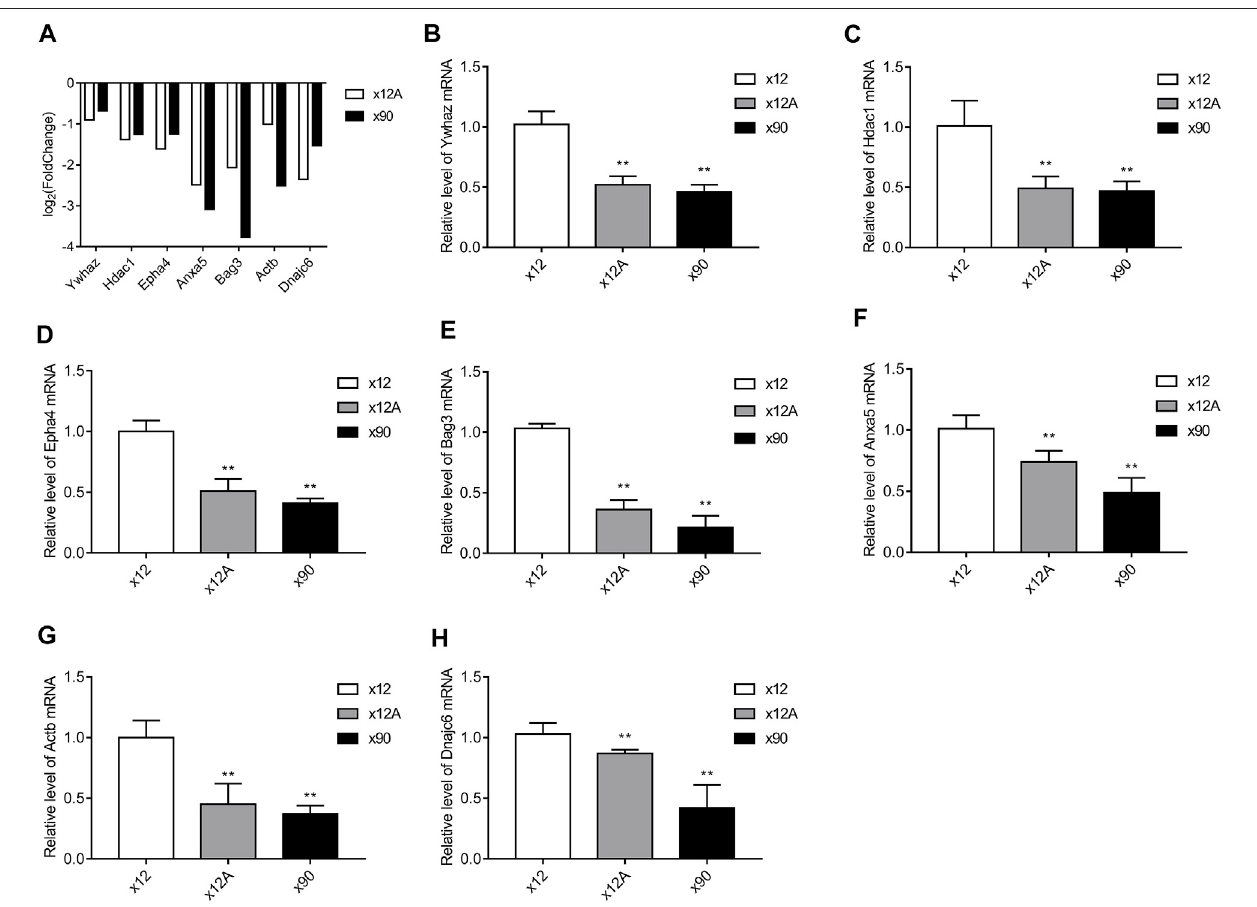
FIGURE 10 | Resultsof RT-qPCR validation. The hub genes obtained from screening against the Alzdata database were matched against the sequencing results. RT-qPCR was used to detect the expression levels of these genes in A β -treated and naturally senescent astrocytes. (A) Expression levels of these genes in transcriptomesequencing,expressedaslog2(foldchange).ExpressionlevelsofthesegenesinA β -treatedcellsandnaturallysenescentastrocytes invitro (B) Ywhaz (C) Hdac1 (D) Epha4 (E) Anxa5 (F) Bag3 (G) Actb (H) Dnajc6 , as determined by RT-qPCR. * p < 0.05, ** p < 0.01, n =